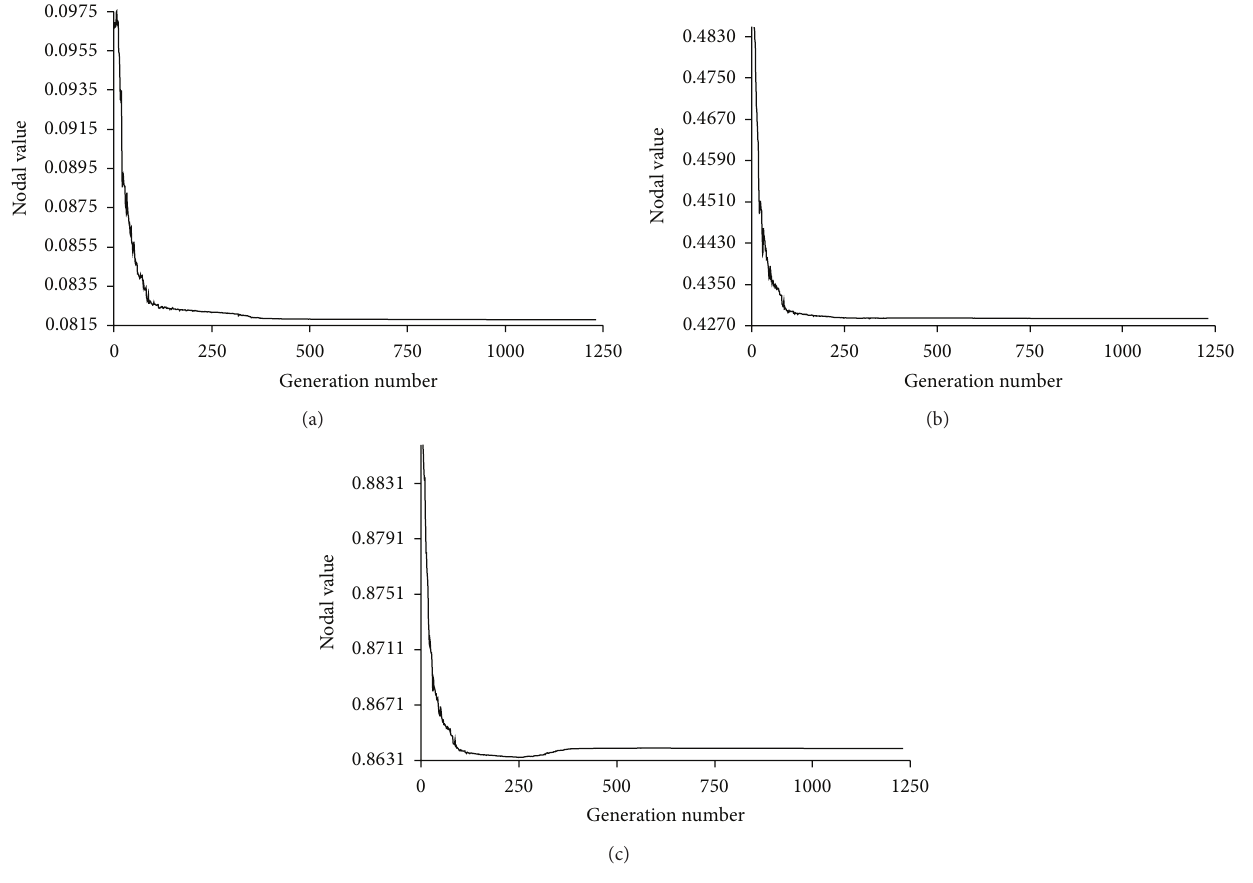
Figure 4: Evolution of the nodal values for Troesch’s problem when 𝜆 = 1 for (a) 𝑦(𝑥 1 ) , (b) 𝑦(𝑥 5 ) , and (c) 𝑦(𝑥 9 ) .